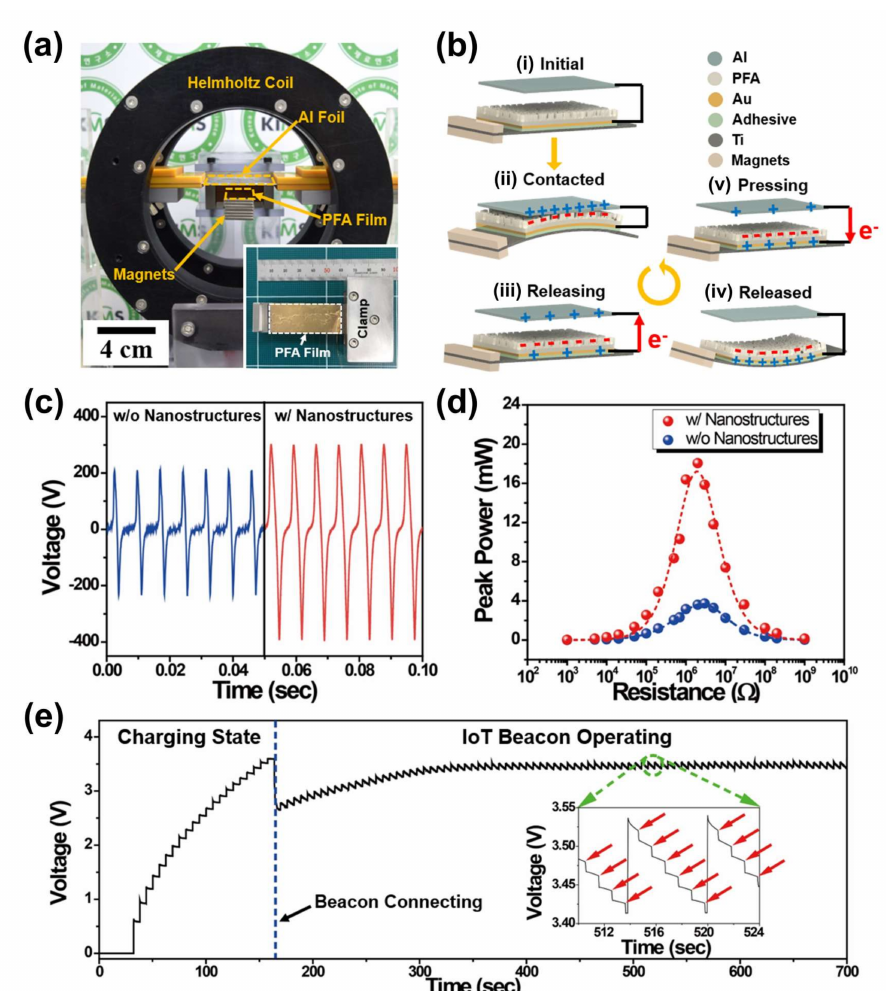
Figure 9. ( a ) Photograph image of MMTEG system installed inside Helmholtz coil. ( b ) Working mecha- nism of MMTEG under AC magnetic field. ( c ) Open-circuit voltage signals from the nano −